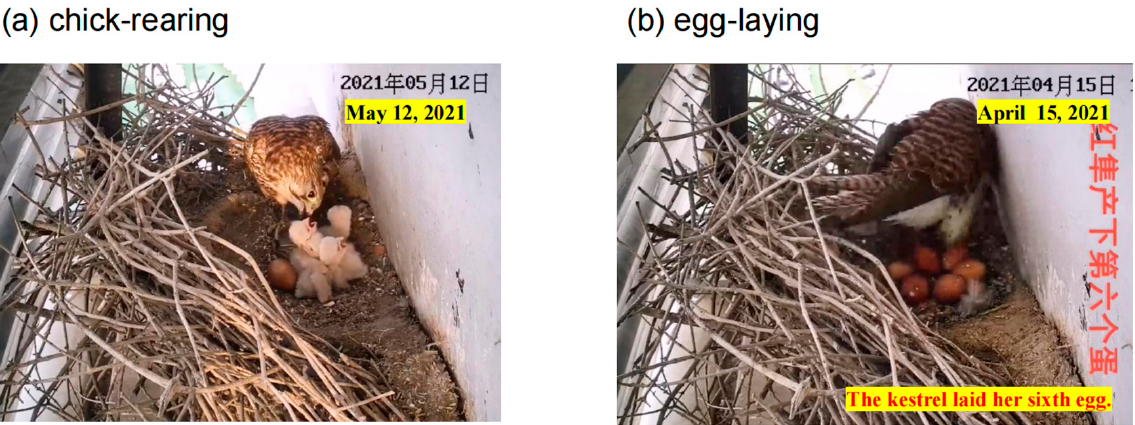
Figure 2. The mother kestrel’s chick‑rearing ( a ) and egg‑laying ( b ) behavior. Notes: The pictures were reproduced from the videos uploaded by Mr. Qin.